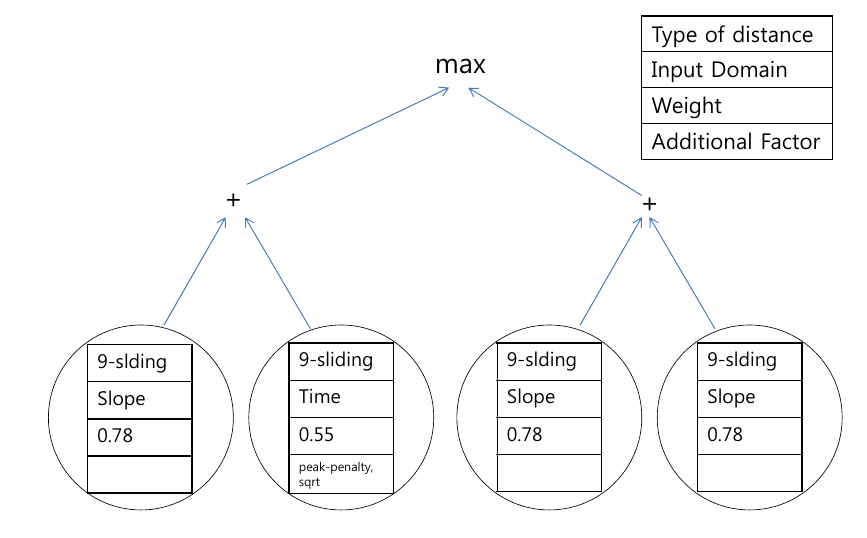
Figure 15. Proposed tree for the southern region using the data of expert #1.